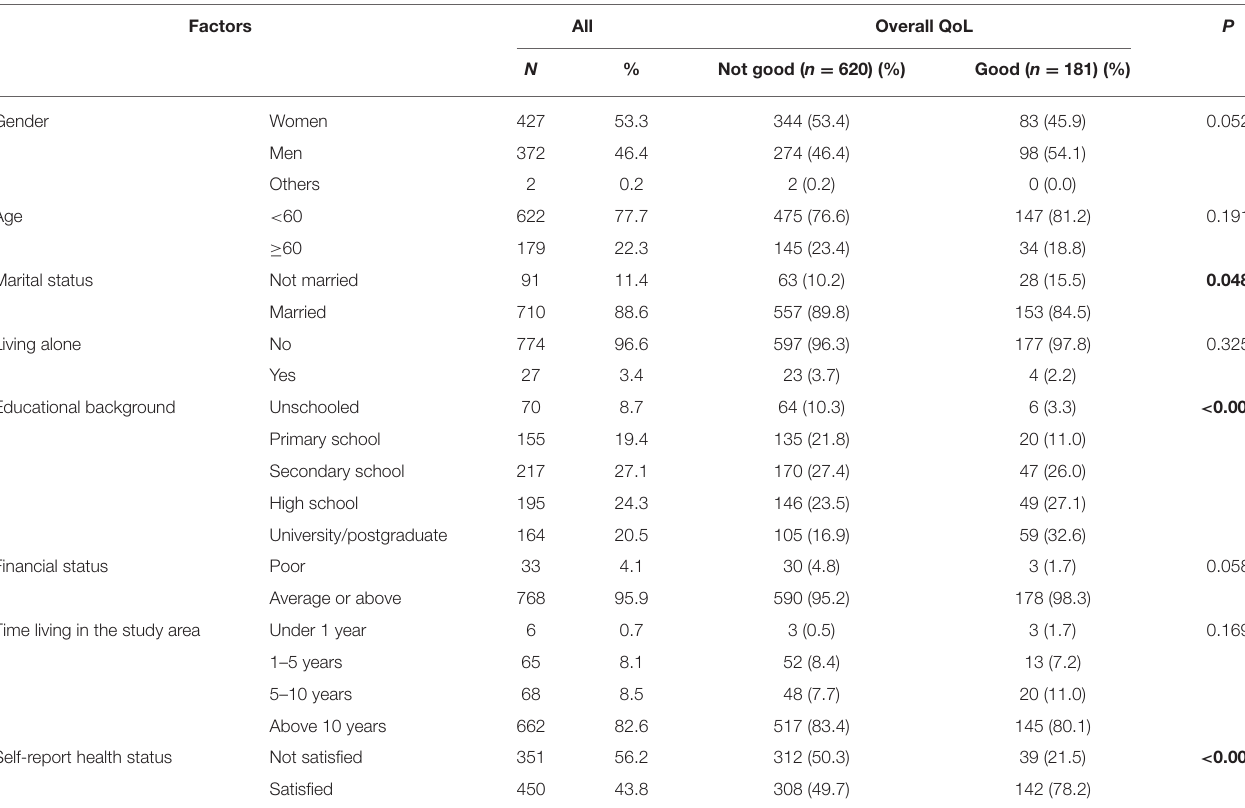
TABLE 2 | General characteristics of the research subjects ( n = 801) and the association with overall QoL based on the chi-squared test.